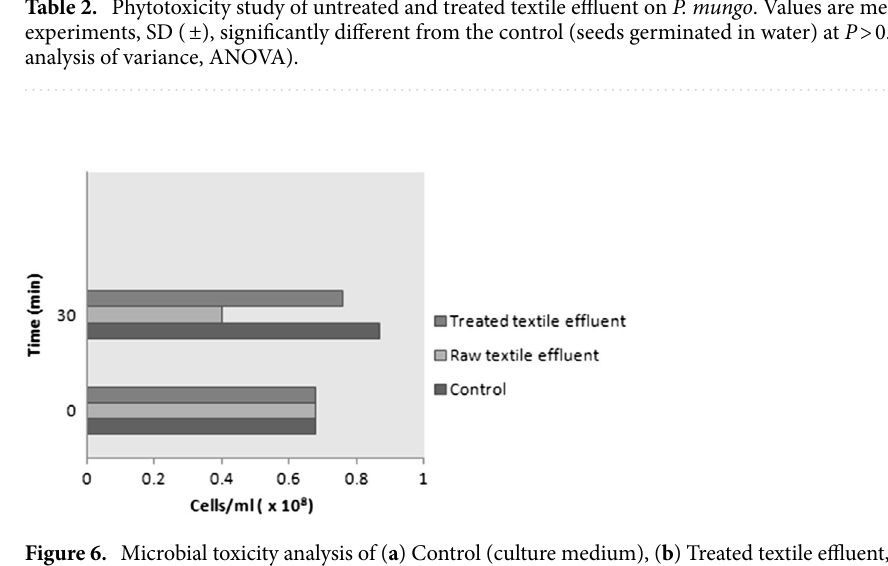
Figure 6. Microbial toxicity analysis of ( a ) Control (culture medium), ( b ) Treated textile effluent, ( c ) Raw textile effluent on E. coli